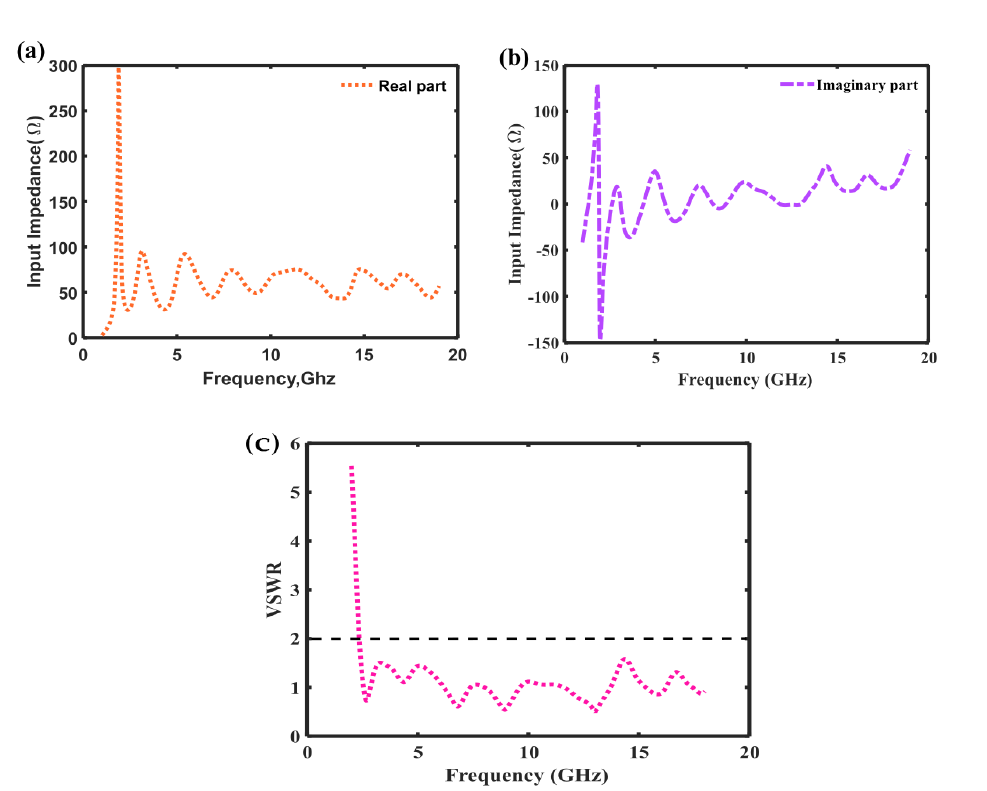
Figure 4. ( a ) Input Impedance (Real Part) ( b ) Input Impedance (Imaginary Part) ( c ) VSWR.